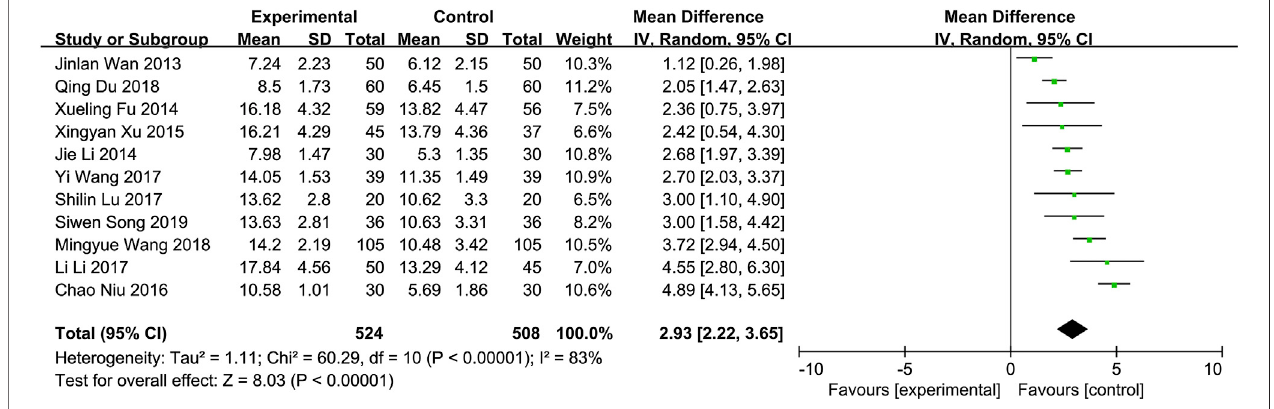
FIGURE 5 | Forest plot for tear fi lm break up time.